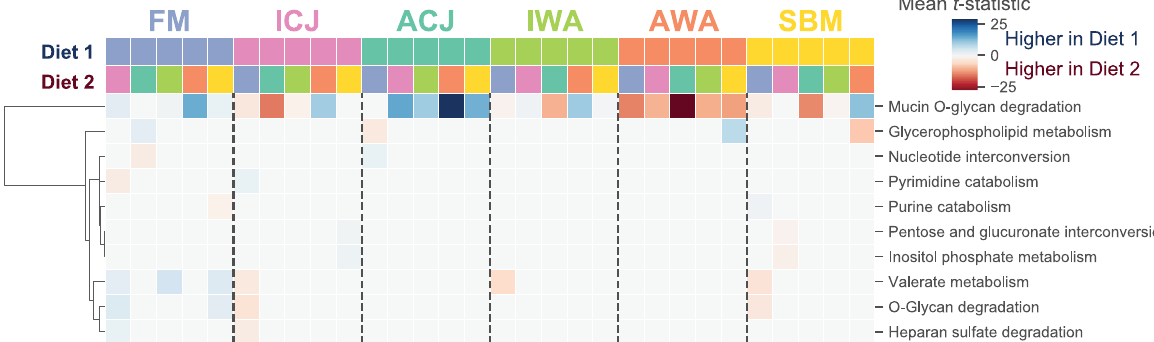
Fig. 7 Hierarchical clustering of the significantly enriched metabolic subsystems between each pair of dietary groups. Columns are diet pairs, rows are metabolic subsystem, and the color of each cell indicates whether the metabolic subsystem was enriched in diet 1 (blue) or diet 2 (red). FM— fishmeal-based; SBM—soybean meal-based; 4 experimental diets containing 300 g/kg SBM and 100 g/kg of ICJ—inactivated Cyberlindnera jadinii